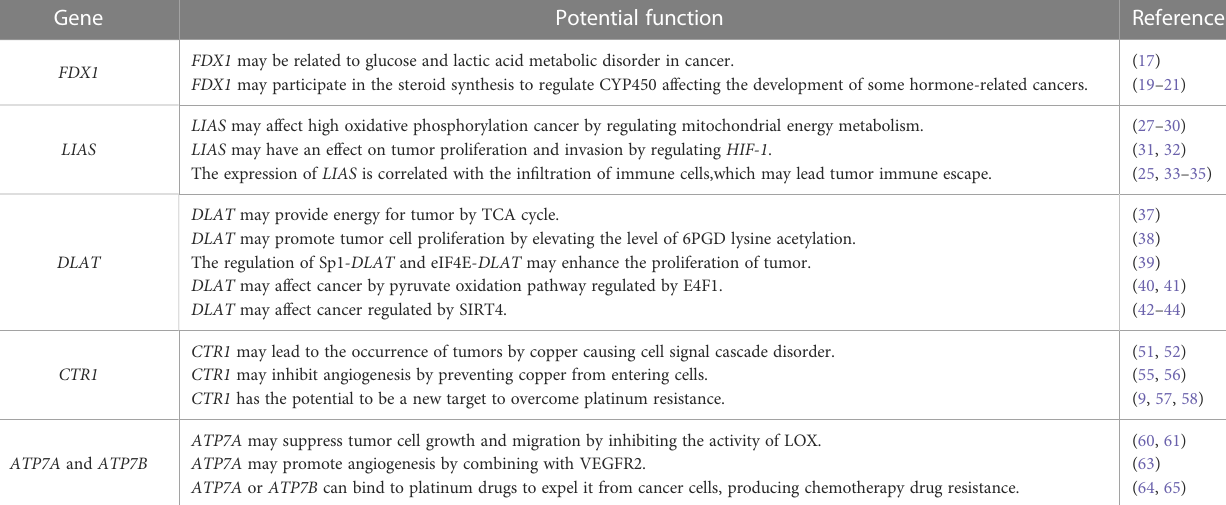
TABLE 1 The potential function of cuproptosis-related genes and copper transporters in cancer. Gene Potential